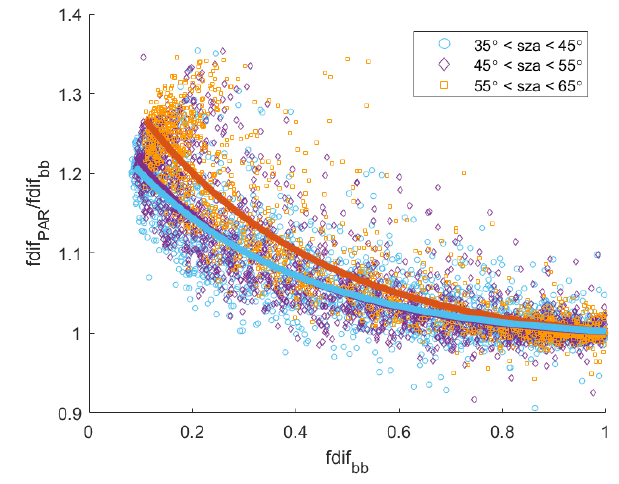
Figure 4. Ratio f dif PAR /f dif bb as a function of f dif bb (SMEAR Estonia). Different curves correspond to the best fits of the data for different solar zenith angles ( sza ).